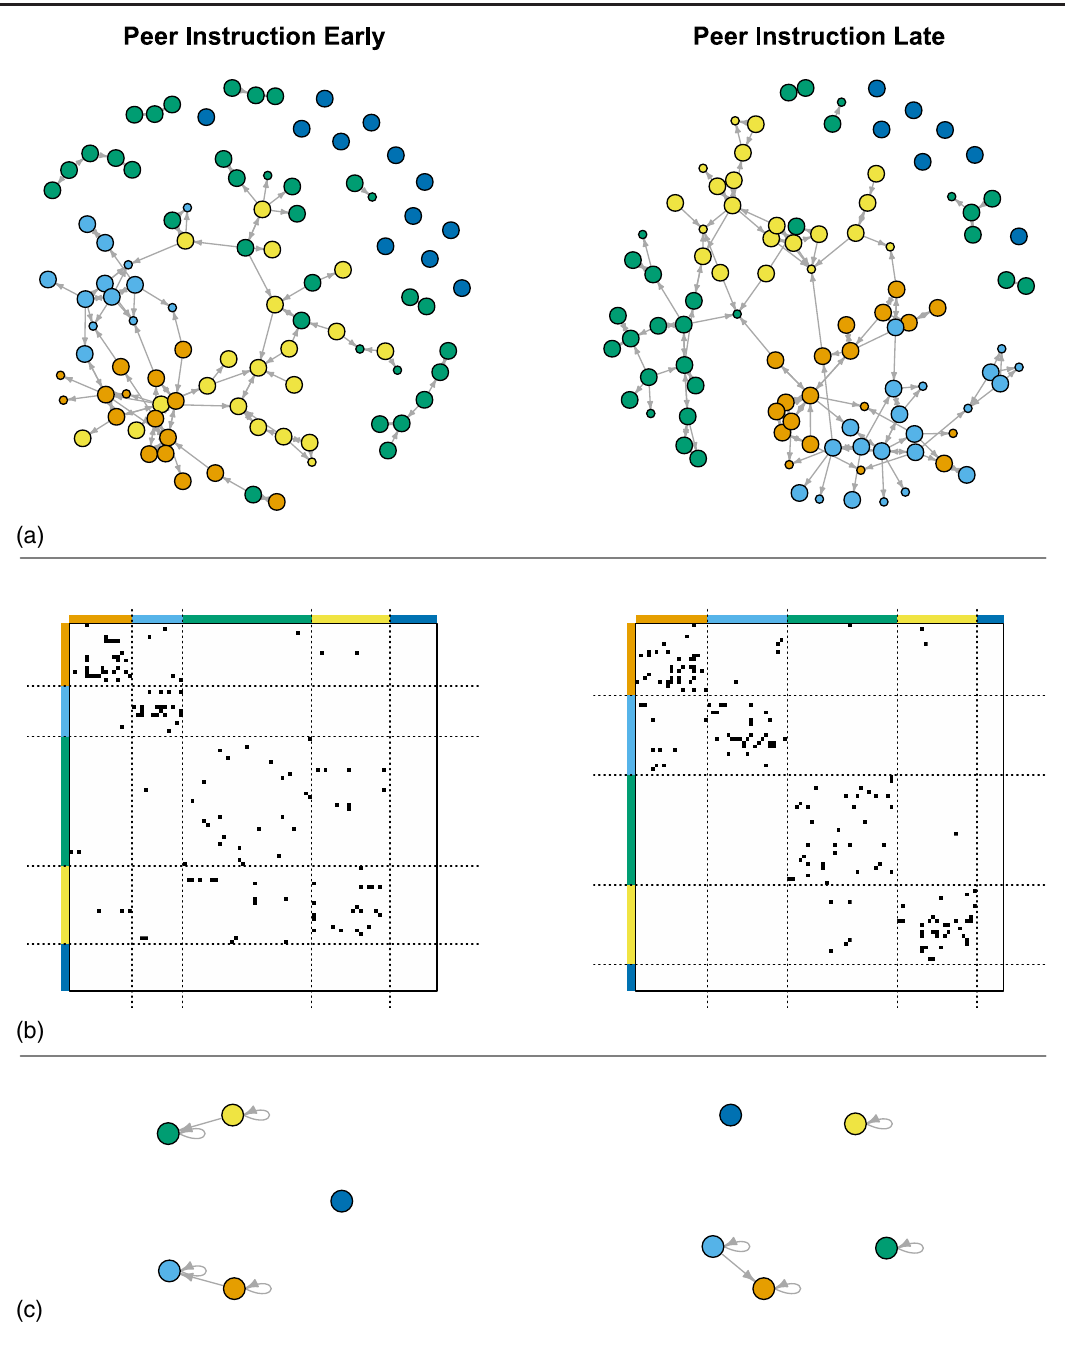
FIG. 3. (a) Network diagrams for week 1 (left column) and week 10 (right column) Peer Instruction section. Smaller circles show students who were named but did not take the survey. Nodes are colored by CONCOR partition, and indicate the same nodes in the blockmodel and reduced network below. (b) The corresponding blockmodel. Each link from the survey is a black square. The dotted lines mark the CONCOR group partitions. Colors along the sides mark which blocks of nodes belong to each partition. (c) Reduced network diagrams. Each circle represents a position from the blockmodel and stands for all of the nodes of the same color in the network diagram. Links in the reduced network plots show connections within and between positions and come from applying a density threshold to the